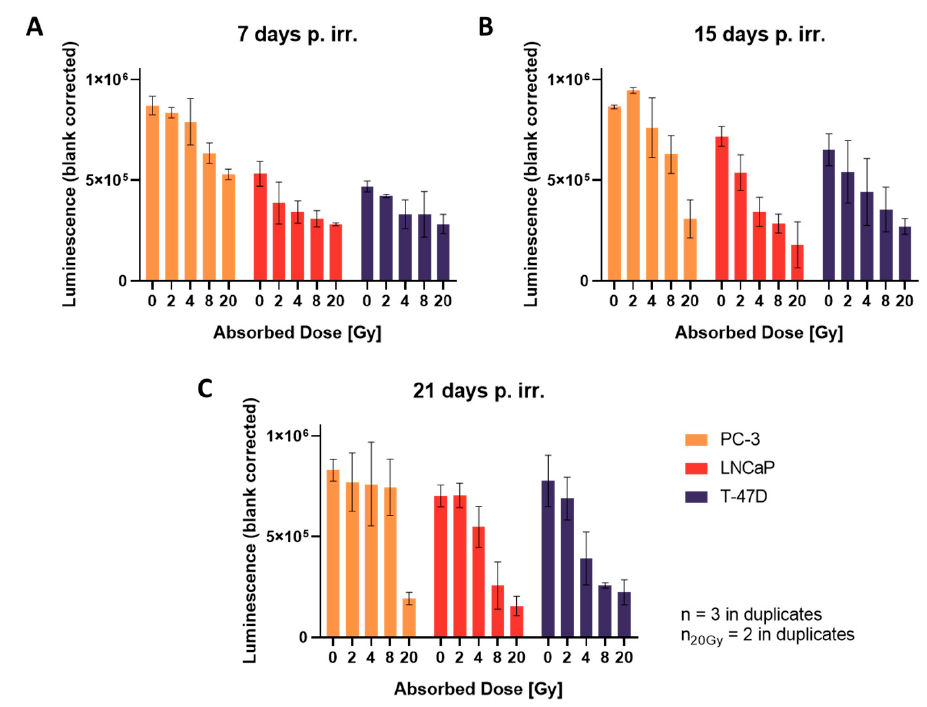
Figure 4. Cell viability of spheroids, ( A ) 7, ( B ) 15 and ( C ) 21 days after irradiation; plotted as mean ± standard deviation from three independent experiments ( n = 3), each performed in duplicates; p. irr. = post irradiation.